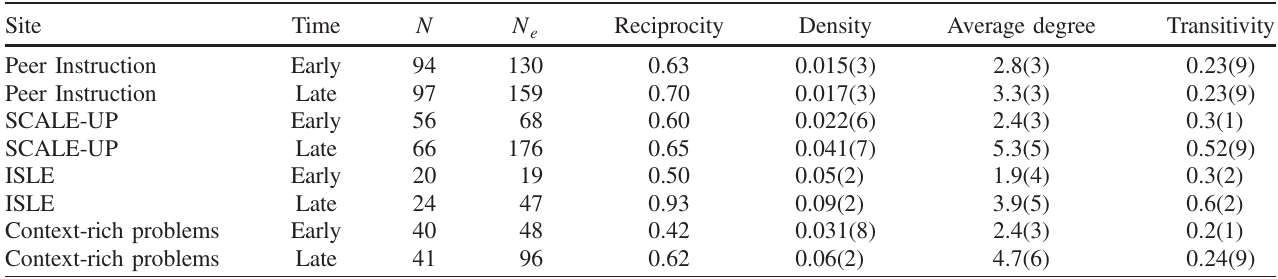
TABLE II. Network descriptive statistics for the classes analyzed: number of nodes ( N ) and edges ( N e ), fraction of named ties that were reciprocated, network density, average degree, and transitivity. For the last three values, the standard error of the final digit is given in